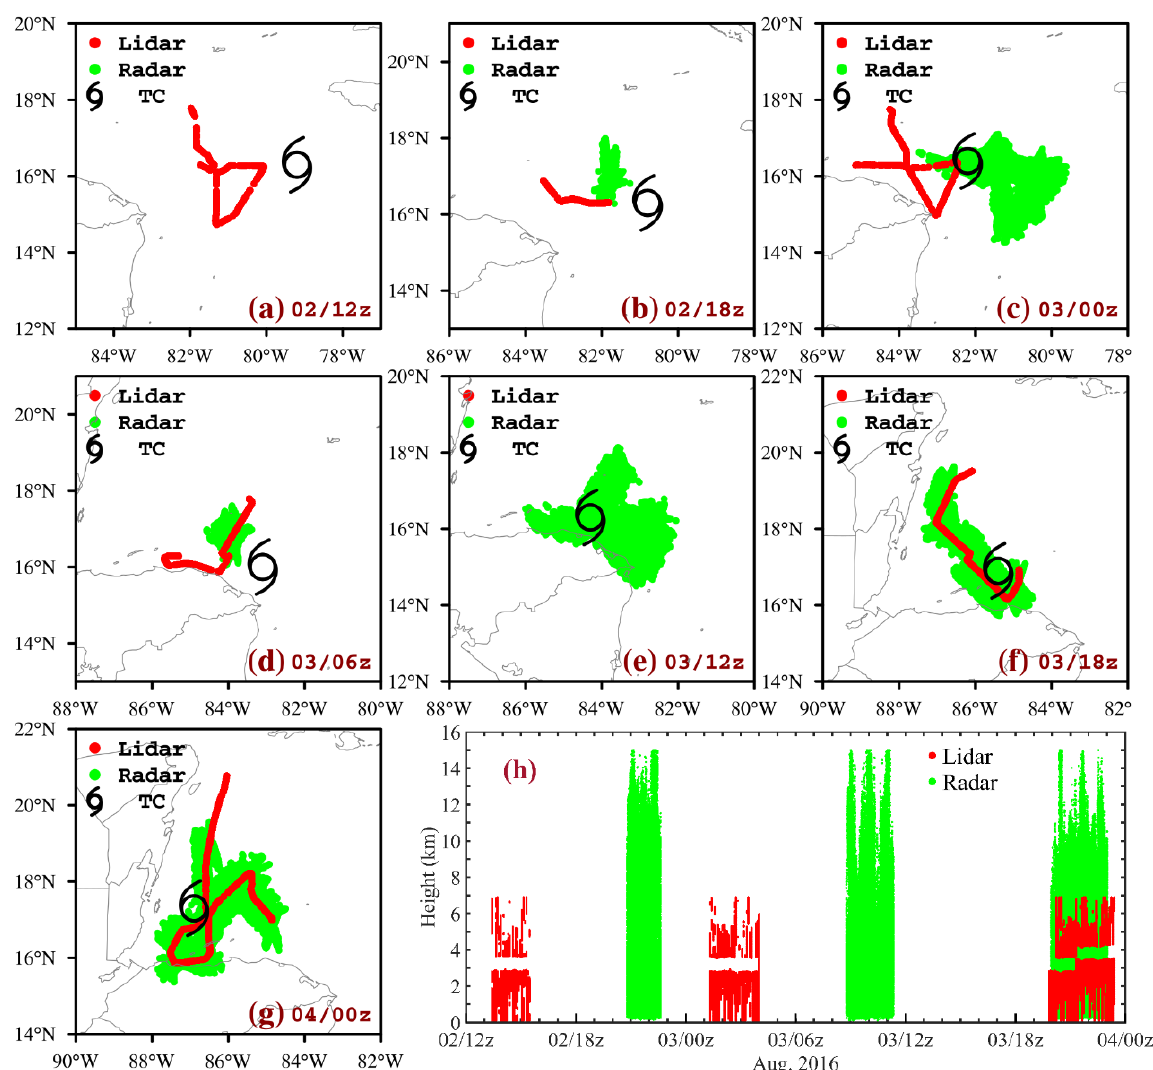
Figure 1. The ( a – g ) horizontal and ( h ) vertical distributions of DWL and TDR data for Hurricane Earl at ( a ) 12 UTC 2, ( b ) 18 UTC 2, ( c ) 00 UTC 3, ( d ) 06 UTC 3, ( e ) 12 UTC 3, ( f ) 18 UTC 3, and ( g ) 00 UTC 4 August 2016.